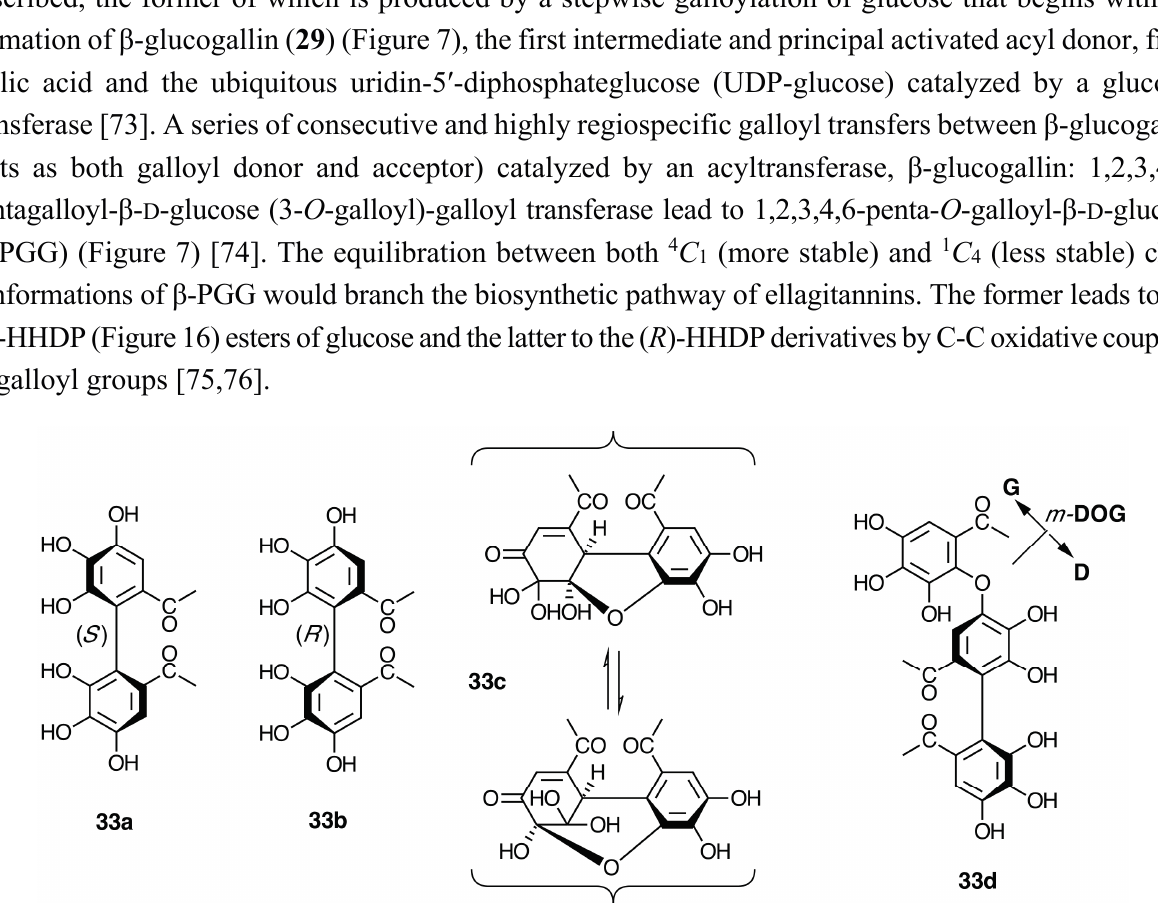
Figure 16 . ( S )-hexahydroxydiphenoyl dehydrohexahydroxydiphenoyl ( R )-DHHDP ( 33c ), and valoneoyl ( 33d ) moieties of oligomeric